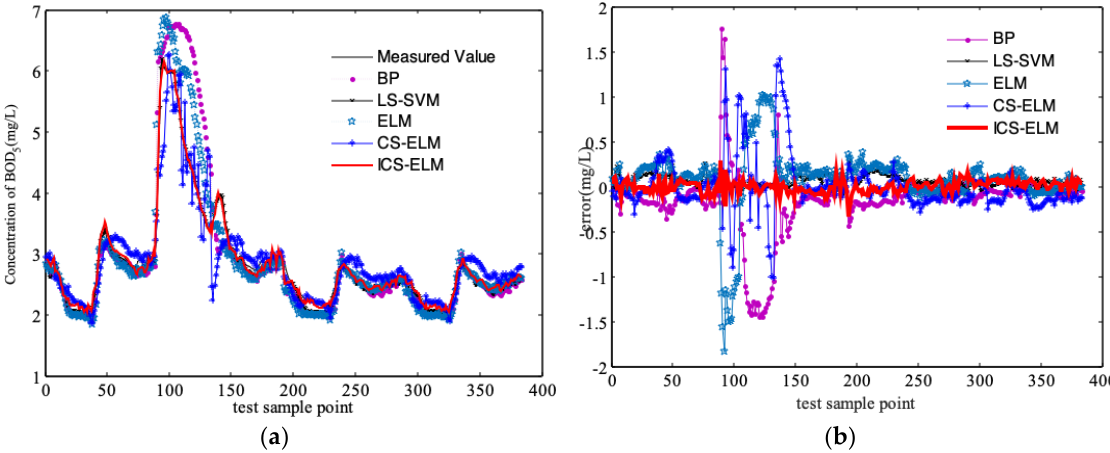
Figure 8. Prediction of effluent BOD under stormy weather condition with a storm event, ( a ) Effluent BOD concentration, ( b ) error in predicting the measured effluent BOD.